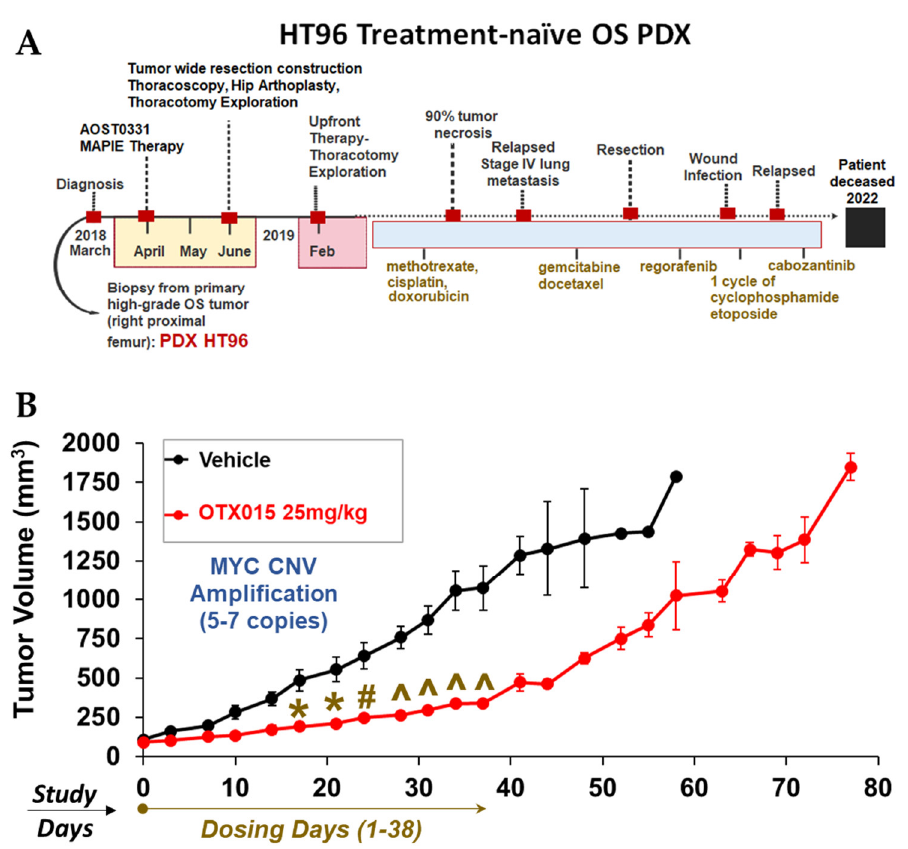
Figure 17. BET inhibitor, OTX015, decreases growth of PDX HT96. ( A ) HT96 PDX was derived from a treatment-naive biopsy sample from a 9-year-old male OS patient. ( B ) HT96 PDX mice were treated for ~6 weeks with 25 mg/kg OTX015 ( n = 5) or vehicle control ( n = 6), BID, PO, daily for 5 consecutive days with a 2-day dosing holiday. All tumor volumes are represented as mean +/− standard error mean (SEM). Two-way ANOVA with Holm–Sidak multiple comparison test; * p < 0.05, # p < 0.001, ^ p < 0.0001. Note: For HT96 study, statistical analyses were conducted up to the point that all mice were still in the study (day 37).